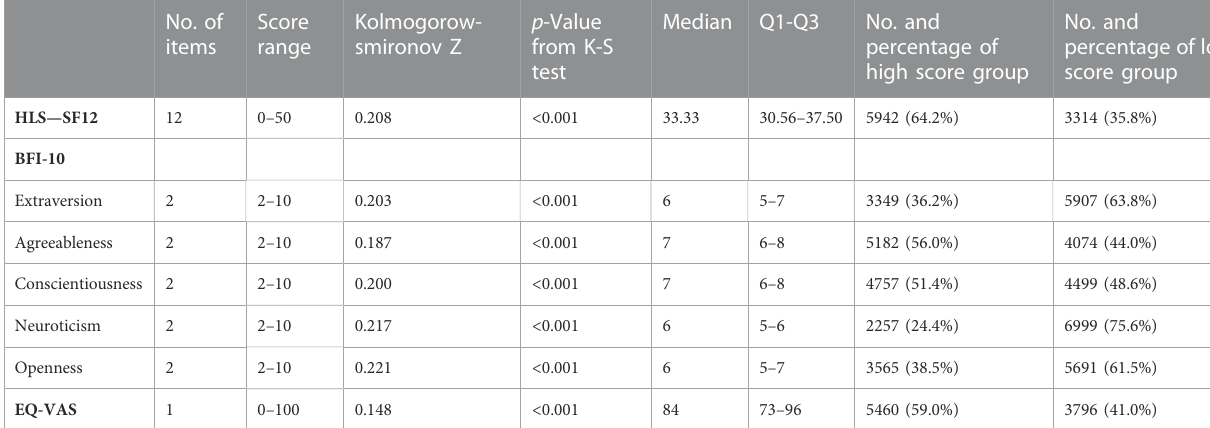
TABLE 2 Respondents ’ scores on HLS-SF12, BFI-10 and EQ-VAS. No. of